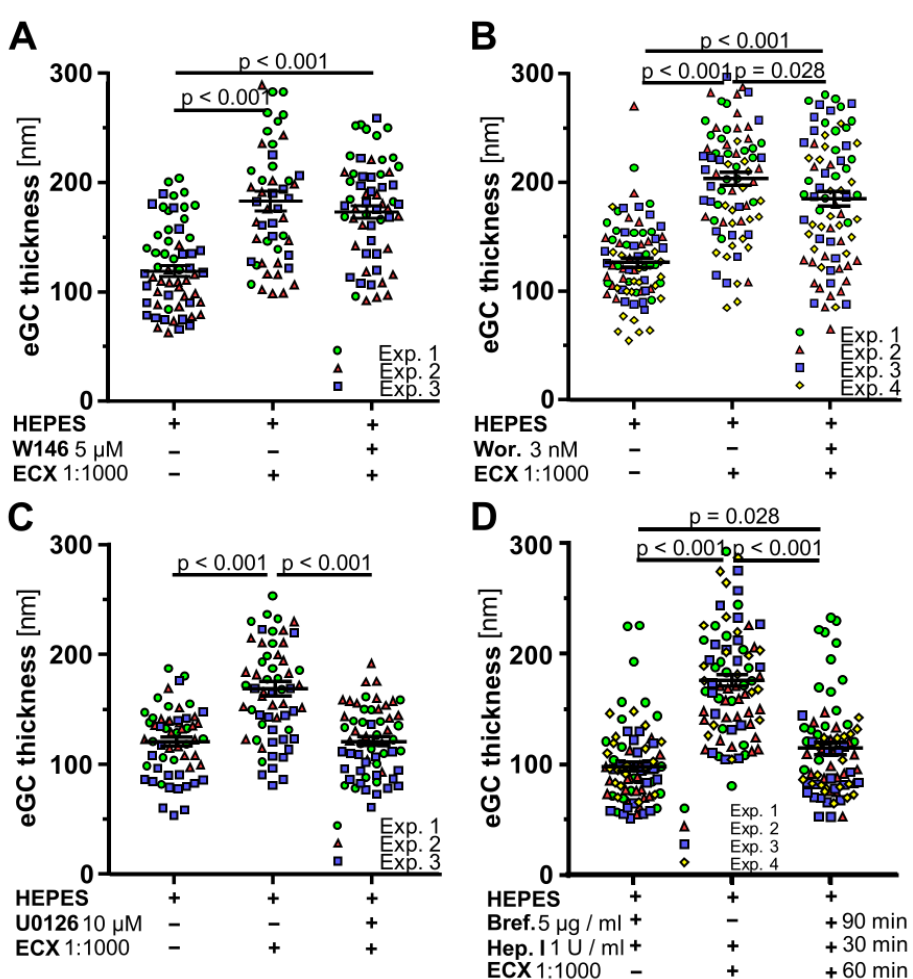
Figure 2. The eGC thickness-preserving effect of ECX is influenced by ERK-MAPK- and PI3K-, but not by S1PR 1 -signaling, whereas the ECX-mediated increase of the eGC thickness is attenuated by inhibition of vesicular transport. ( A – C ) Differences in eGC thickness in living endothelial cells (EA.hy926) measured via atomic force microscopy following the incubation with ECX 1:1000 in solvent (HEPES buffer) or the additional incubation with 5 µ M of the S1PR 1 inhibitor W146, 3 nM of the PI3K inhibitor Wortmannin (Wor.) or 10 µ M of the ERK-MAPK inhibitor U0126. The incubation time immediately prior to the experiment (Exp.) was 60 min. Pre-incubation with the inhibitors was performed in cell culture medium overnight. ( D ) Here, living endothelial cells were firstly incubated for 90 min with HEPES buffer with or without 5 µ M Brefeldin A (Bref.), followed by a 30 min incubation with 1 U/mL heparinase I (Hepar. I) and another 60 min incubation with or without ECX 1:1000 (in solvent still containing Brefeldin A, but not heparinase I), before atomic force measurements were performed. Each dot represents the mean of 4 to 8 force-distance curves per cell and a minimum of 15 cells, data are presented as mean ± SEM, n = 3, respectively, 4 independent experiments